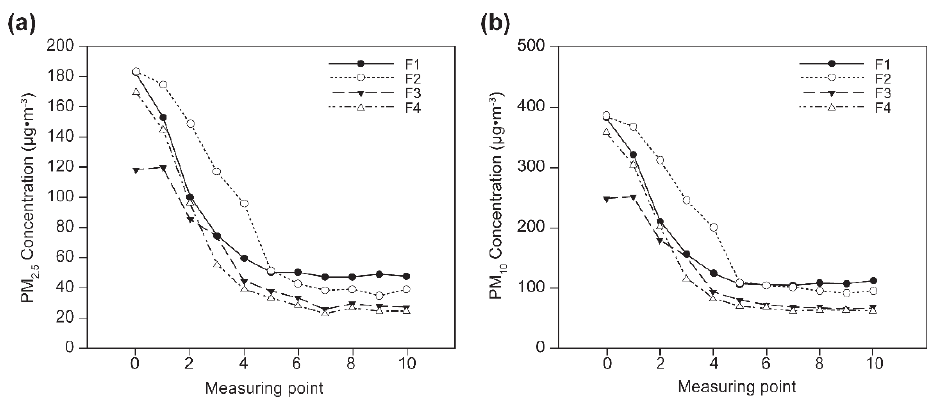
Figure 5. Comparative velocity analysis for single- and multi-layer vegetation structures: ( a ) E1 and ( b ) E2. ( a ) describes the flow in the horizontal direction due to the generation of a second vortex below zone A and the large flow in zone B. ( b ) shows that a second vortex was not generated in zone A, resulting in vertical flow and reduced flow in zone B.